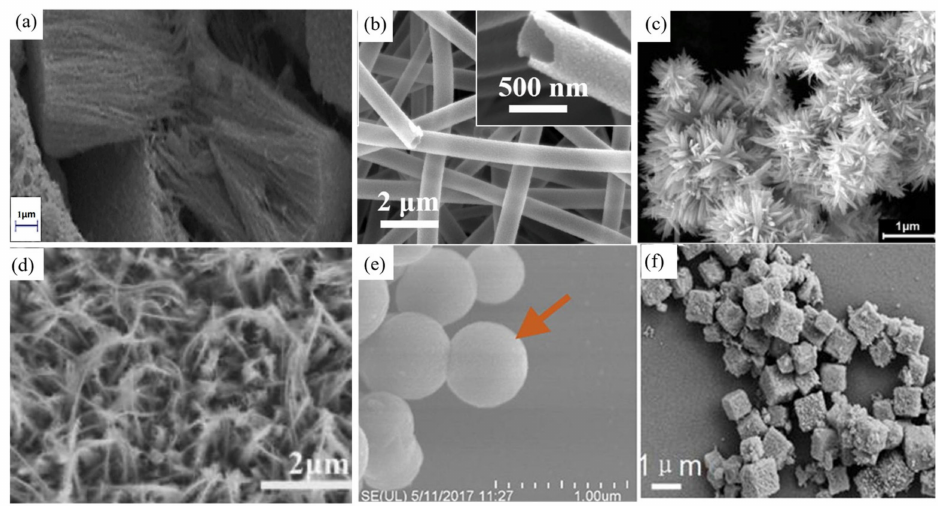
Figure 14. The SEM images of ZnFe 2 O 4 with different morphologies: ( a ) nanowire (field